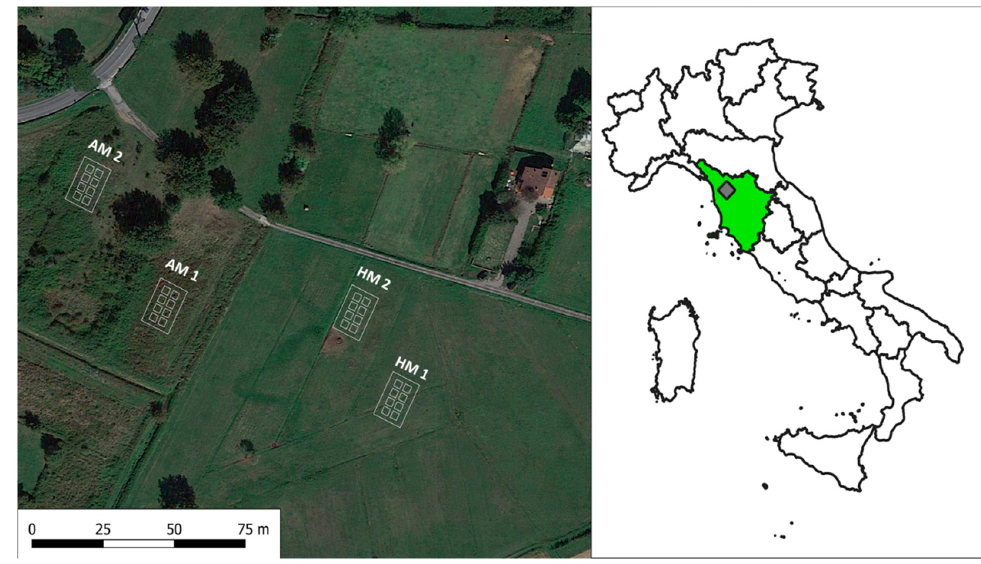
Figure 2. Map of the site with the position of the four blocks and the subplots, on the right HM (=hay meadow) on the left AM (=abandoned meadow).